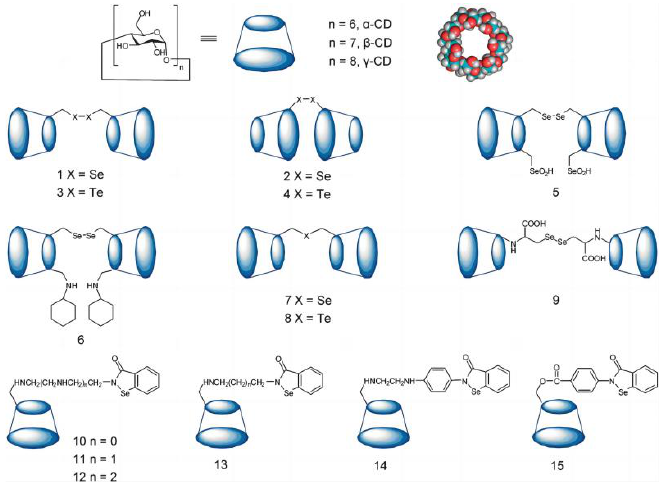
Figure 4. Graphic representation of a series of cyclodextrin-based selenoenzyme mimics. Reproduced with permission from X. Huang, et al. [10].